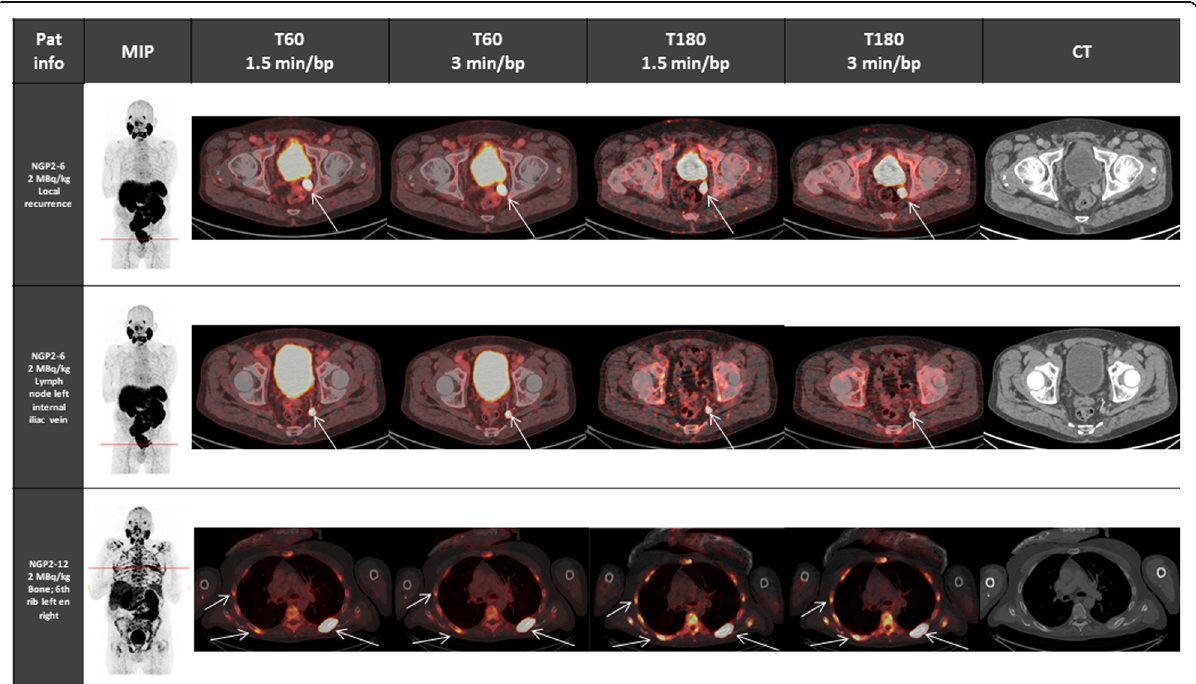
Fig. 4 Overview of patient images who were administered 2 MBq/kg who presented with common lesion locations: local recurrence (first row), lymph node metastases (middle row) and bone metastases (last row), each presented as a MIP image (at T60, 3 min/bp) followed by axial images (axis line displayed on MIP image) of all reconstructed time frames (T60, 1.5 and 3 min/bp and T180, 1.5 and 3 min/bp), and the high dose CT